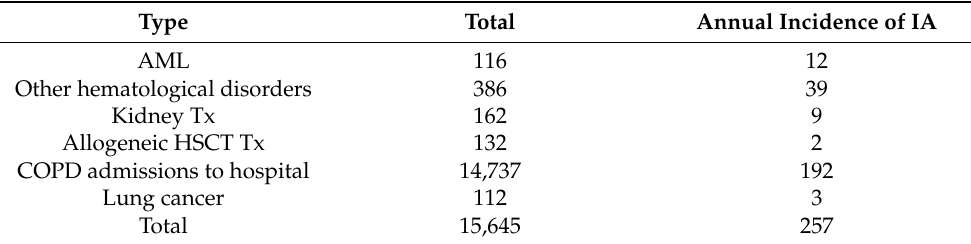
Table 3. Invasive aspergillosis in leukemia and transplant